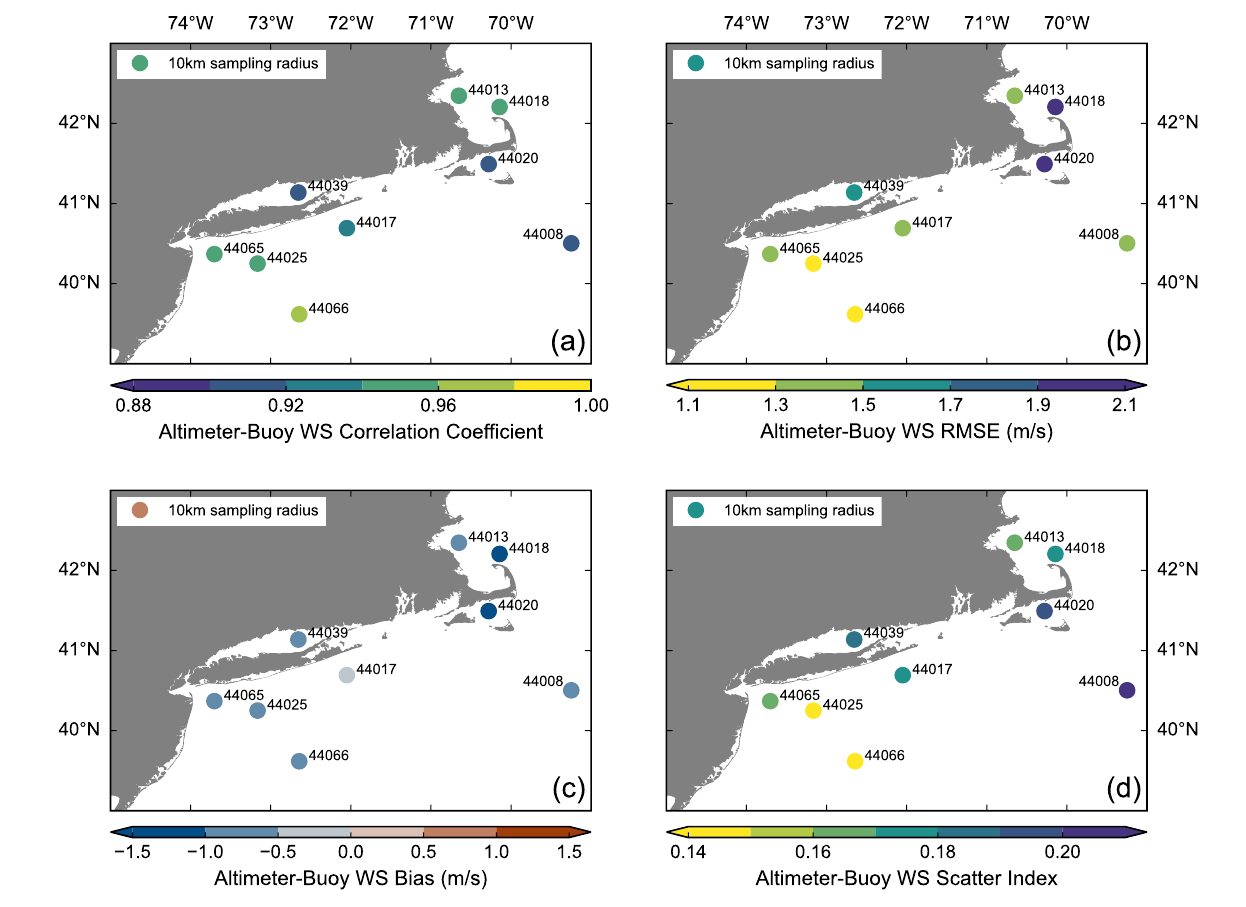
Figure A3. WS validation metrics of the collective altimeter dataset against the collocated buoy observations after being adjusted to 10 m height, assuming neutral stability, at each station. Pearson’s correlation coefficient ( a ), RMSE ( b ), Bias ( c ), and SI ( d ) maps visualize the comparison spatially in the